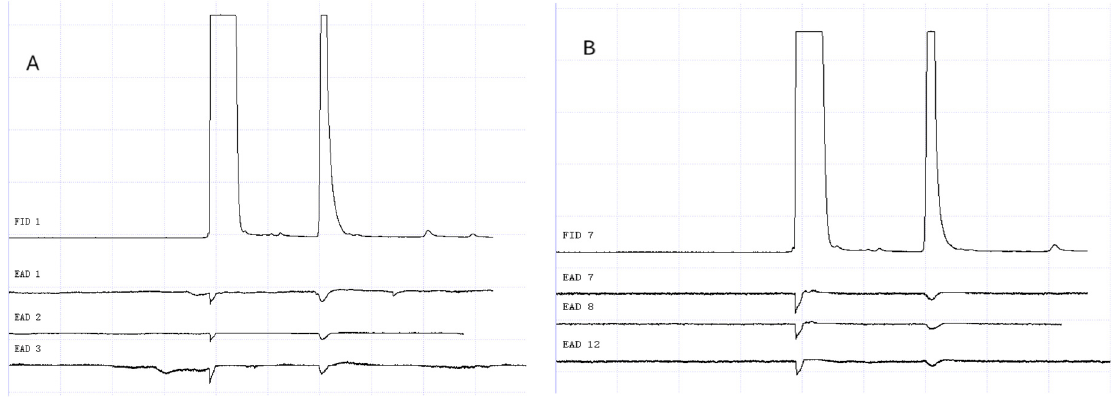
Figure 14. GC-EAD responses of 1-day-old W. magnifica to propyl butyrate. ( A ) Male. ( B ) Female.